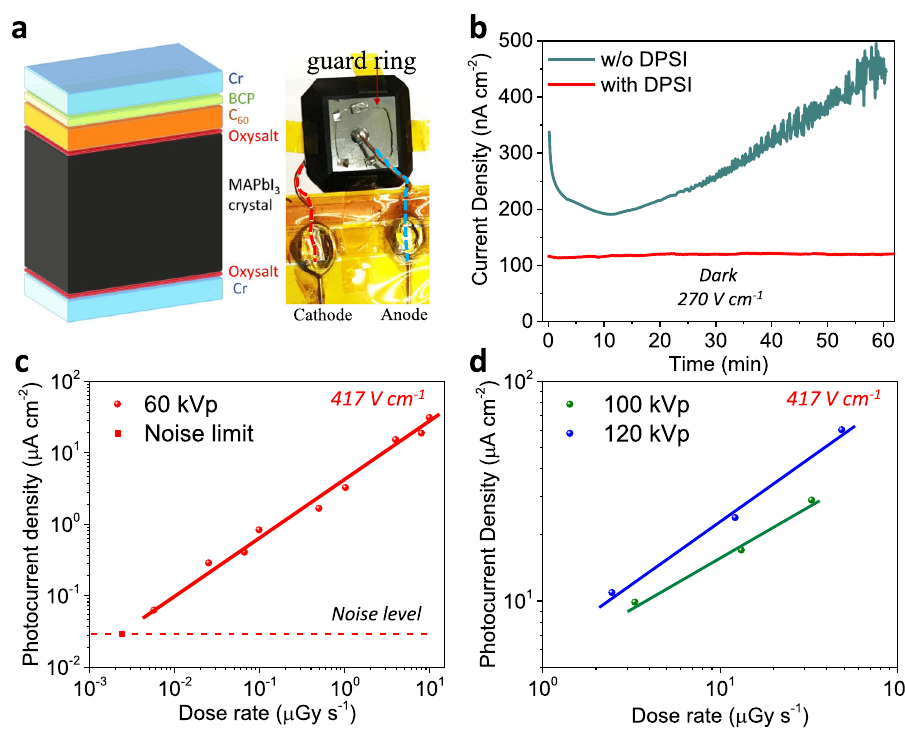
Fig. 4 X-ray detection performance. a Device structure scheme and a photo of the as-fabricated device. b Dark current density of the crystals under a same electric fi eld of 270 V cm -1 at ambient air without encapsulation. The crystals were both polished and passivated by oxysalt. The thickness of the crystal with DPSI here is 3.7 mm, and the applied bias was − 100 V. c Device output current under 60 kVp X-ray of different dose rate with noise limit. d Device output current under 100 kVp and 120 kVp X-rays. This crystal thickness is 2.4 mm, and the applied bias was − 100 V.